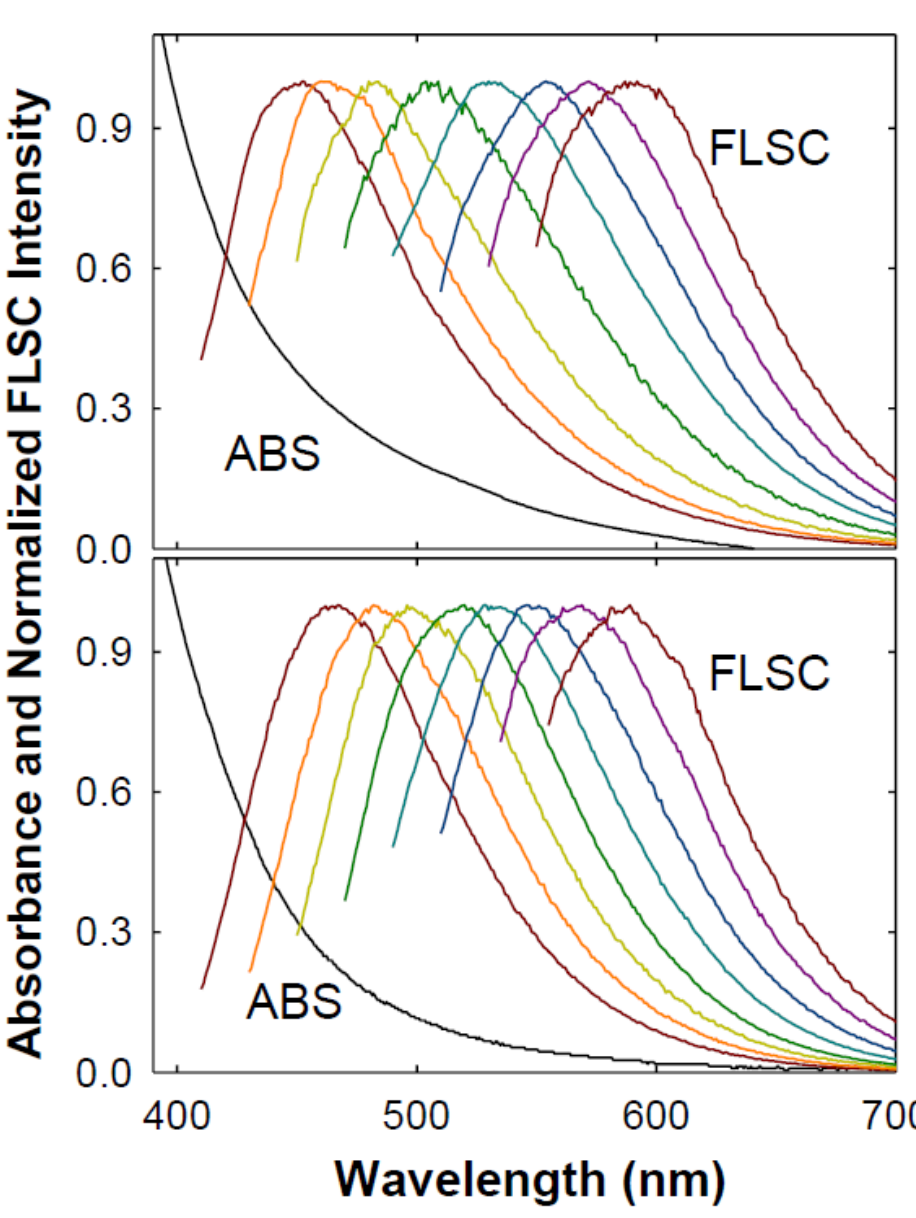
Figure 3. Absorption (ABS) and fluorescence (FLSC) spectra of NEC-CDots (upper) and EDA-CDots (lower), both in chlorobenzene. The excitation wavelengths were (corresponding to the FLSC spectra from left to right) 400 nm–560 nm in 20 nm increments.